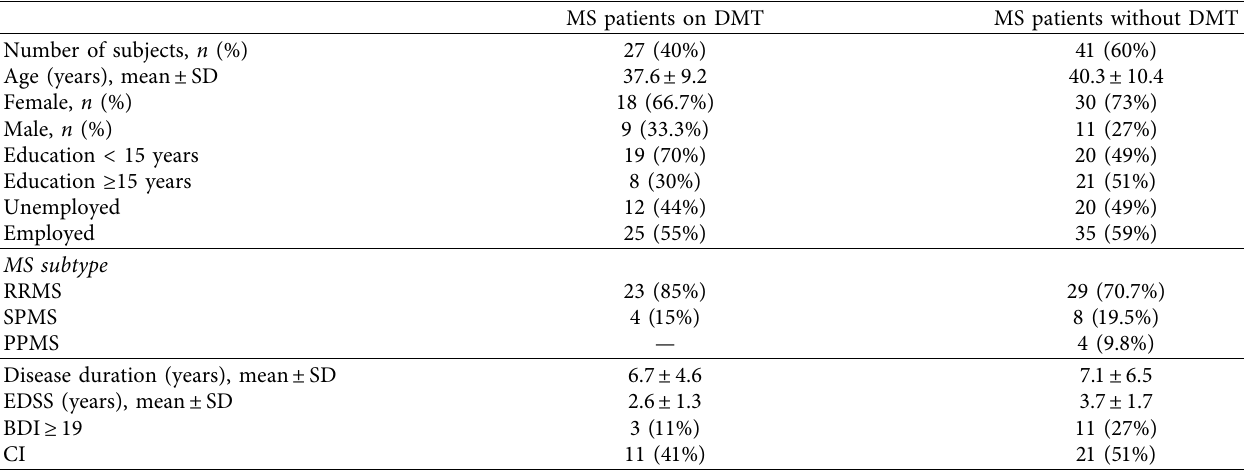
Table 5: Characteristics of MS patients with and without DMT.